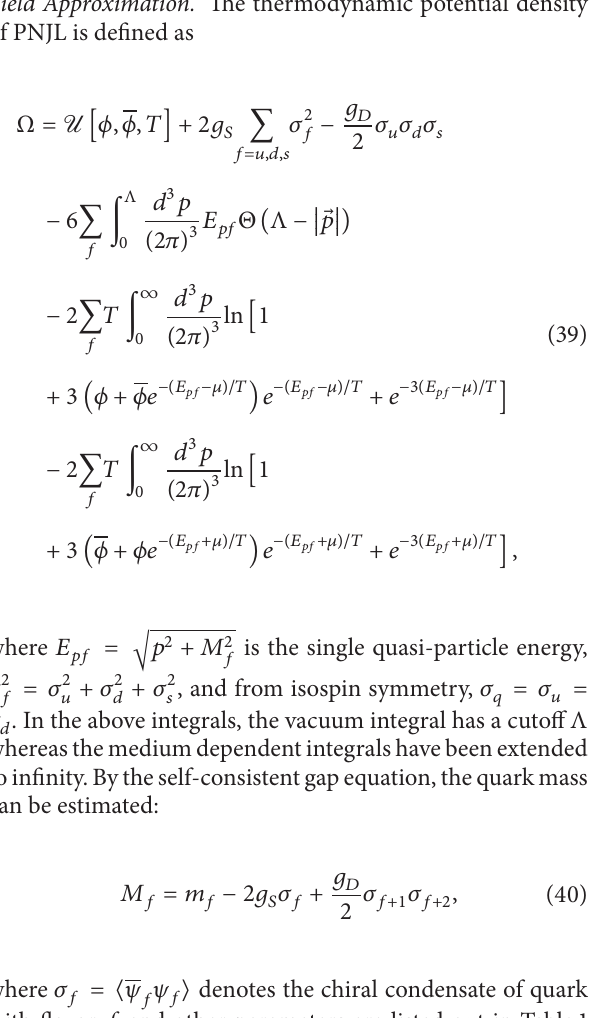
Table 1: Parameters of the SU(3) PNJL